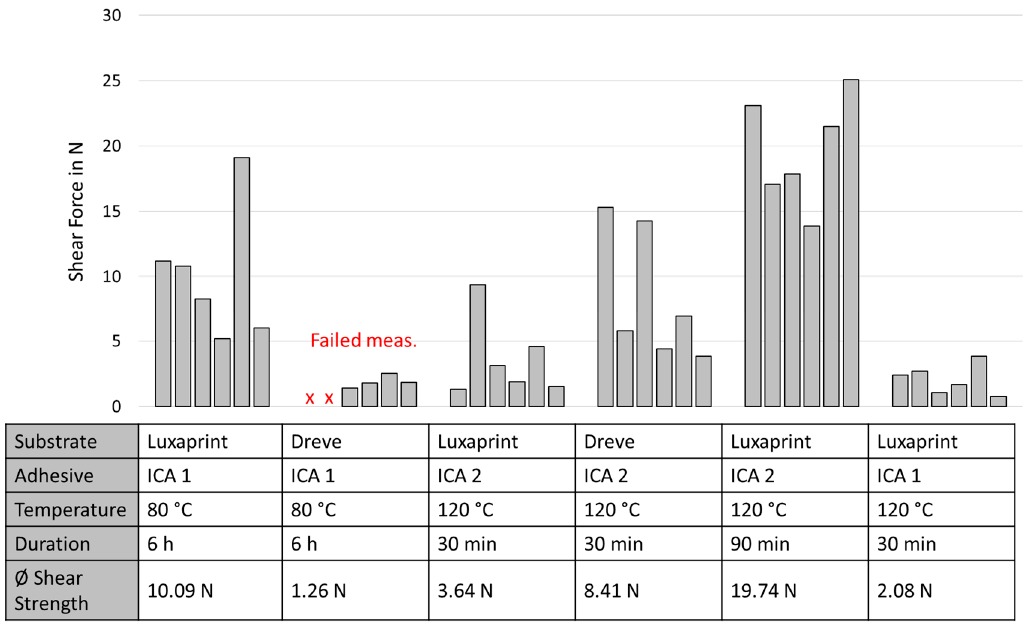
Figure 16. Shear forces of 0603 SMD components with different curing profiles.